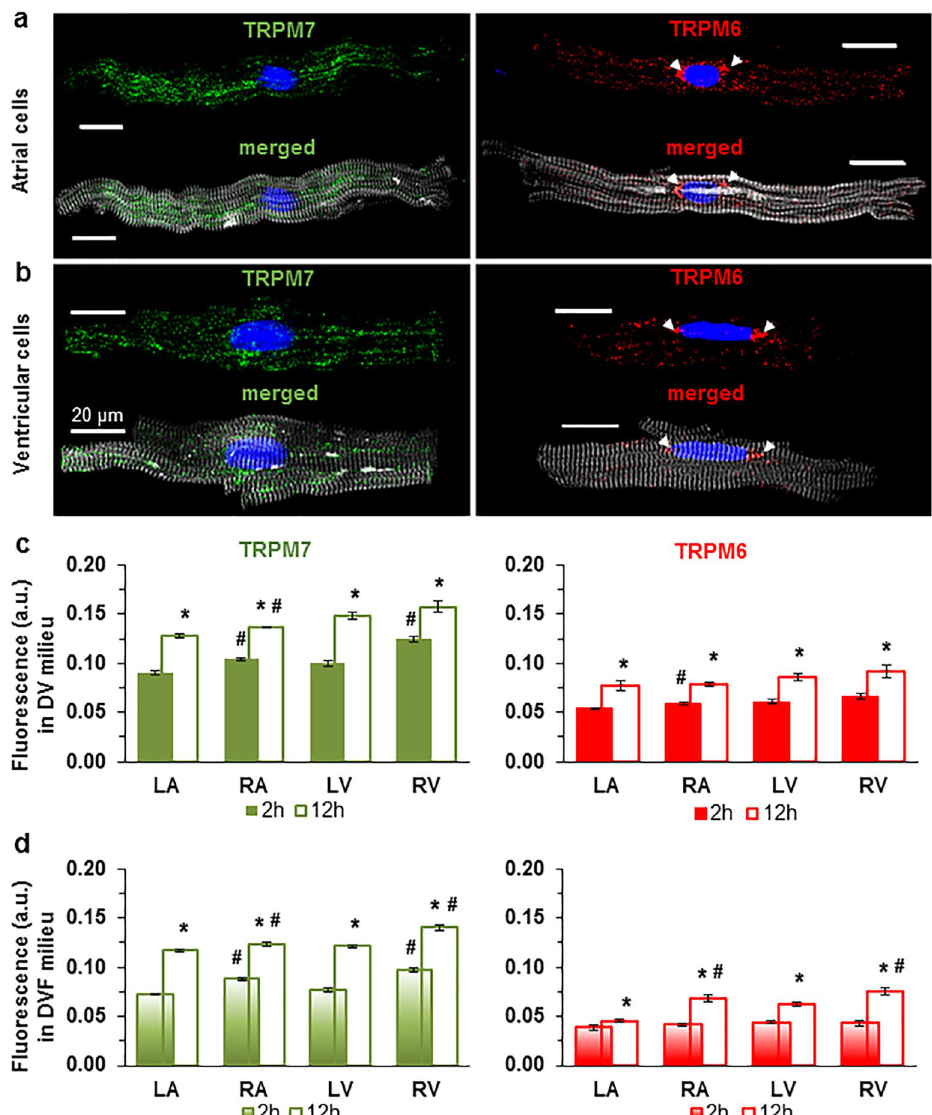
Figure 1. Immunofluorescence of TRPM7 and TRPM6 proteins in all cells used. Image acquisition performed using confocal laser scanning microscope ( a , atria; b , ventricle). Immunofluorescence of confocal z-stack of cardiomyocytes with immunodetected TRPM7 and TRPM6 proteins, respectively. Alexa Fluor 488 and Alexa Fluor 546 for the TRPM7 and TRPM6 protein appear in green and red, respectively. Alexa Fluor 405 for F-actin cytoskeleton appears in surrogate grey. Hoechst 33342 for nuclei appears in blue (the arrowheads indicate the localization of TRPM6 protein in the perinuclear area). ( c , d ) Quantification of immunofluorescence levels of the TRPM7 ( green ) and TRPM6 ( red ) proteins in cardiomyocytes from four chambers of the heart (left atrium, LA; right atrium, RA; left ventricle, LV; and right ventricle, RV), under experimental conditions with ( c ) and without ( d ) divalent cations in the extracellular milieu, respectively. Cardiomyocytes were fixed following 2 h ( filled columns ) or 12 h ( unfilled columns ) after cell isolation. Mean data provided in arbitrary units (a.u.) (Supplementary Table 1 online). A blinded study-design (with the investigator reading the fluorescence not knowing the cell incubation conditions) was used for the detection of protein concentration during various experimental conditions. * P < 0.05 2 h vs. 12 h and # P < 0.05 right-sided vs. left-sided heart chambers. Scale bars indicate 20